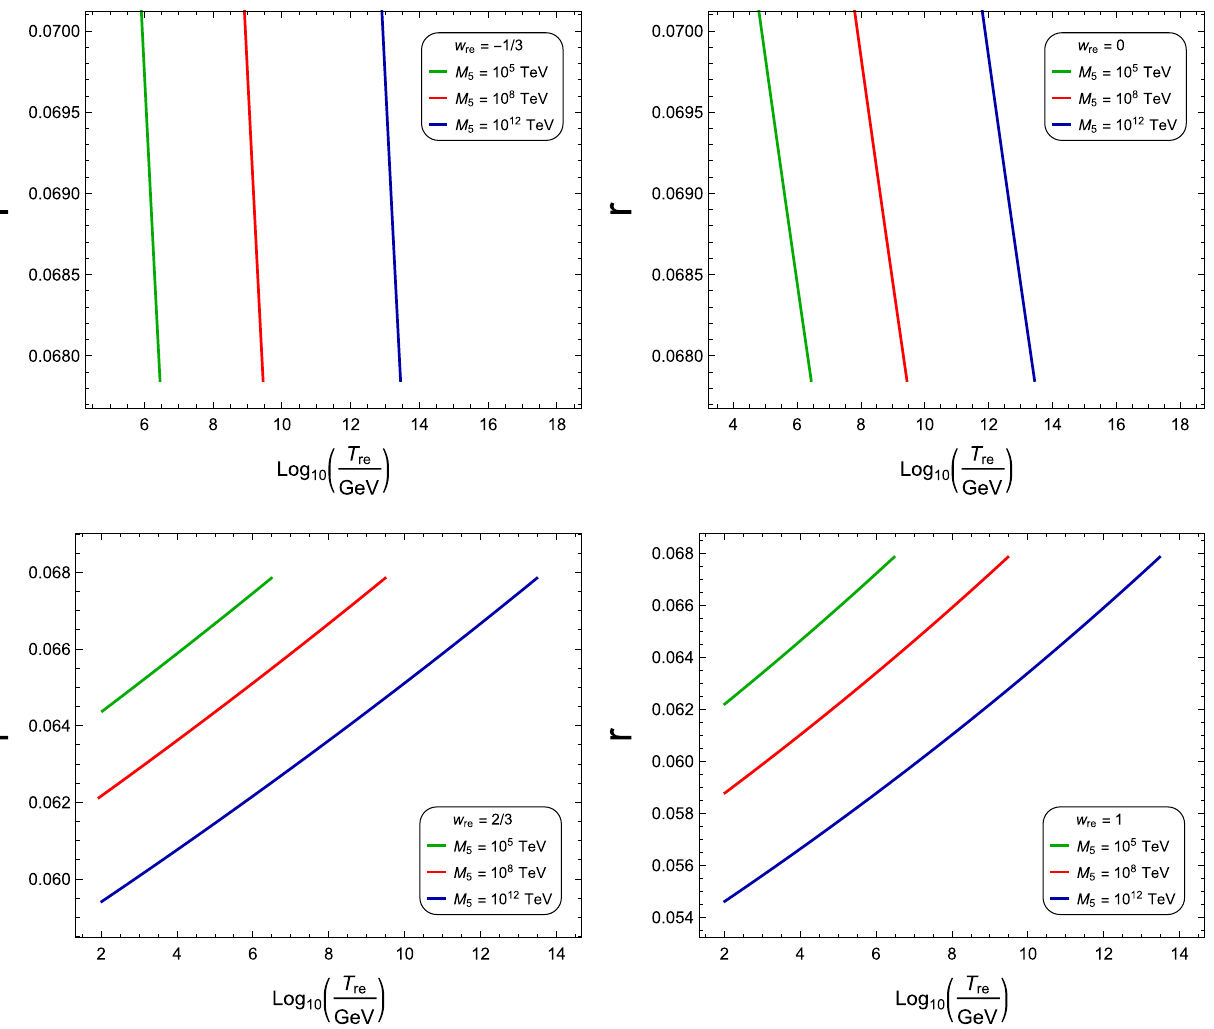
Fig. 8 Plots for the tensor-to-scalar ratio against the reheating temperature for quadratic Hilltop inflation for w re = − 1 / 3 , 0 , 2 / 3 , 1 and α = 0 . 0135. The green, red and blue lines corresponds to a mass of M 5 = 10 5 TeV, M 5 = 10 8 TeV and M 5 = 10 12 TeV